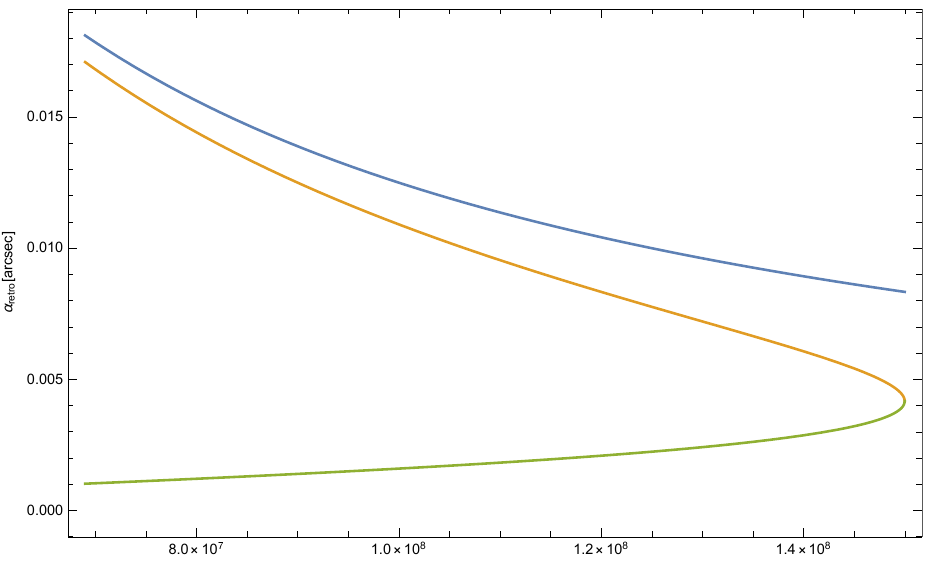
Figure 13. α for light of retrograde motion: The horizontal axis denotes the impact parameter for a photon orbit, and the vertical axis denotes the deflection angle of light. The blue curve is the asymptotic deflection angle by the Kerr black hole. The orange curve is the deflection angle with finite-correction by the Kerr black hole. The green curve shows the difference between the asymptotic bending angle and the deflection angle with finite-correction by the Kerr black